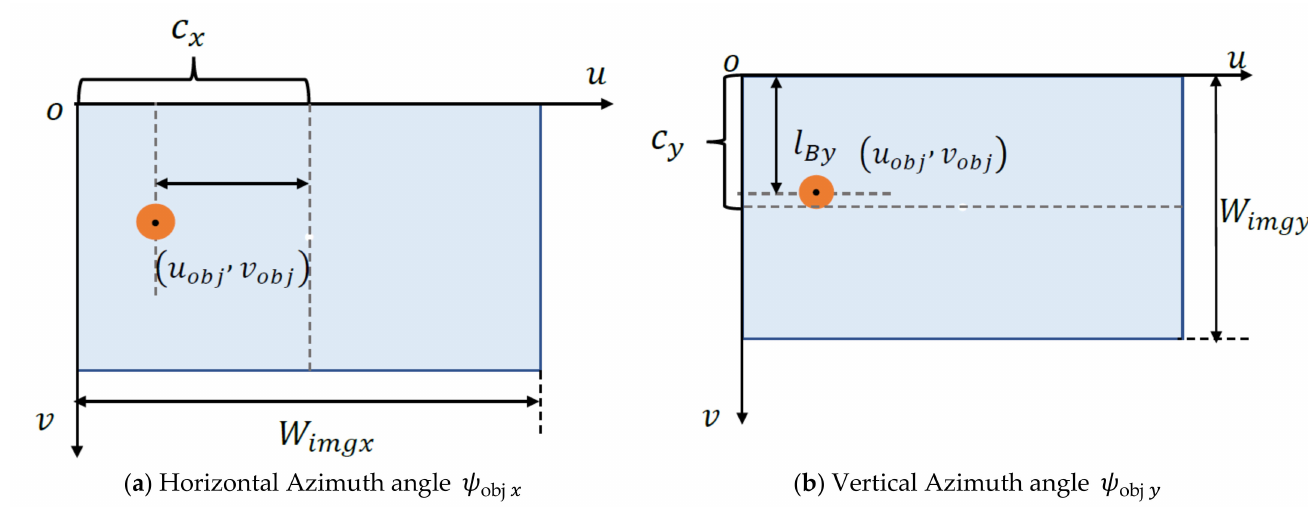
Figure 6. Calculation of Azimuth